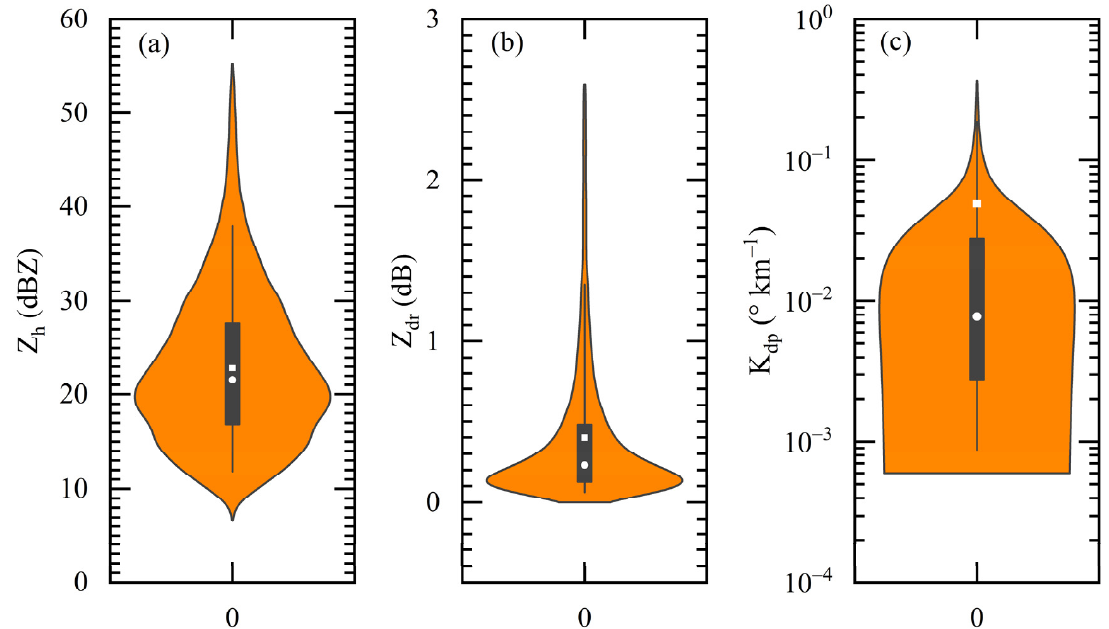
Figure 8 . Violin plots of ( a ) Z h , ( b ) Z dr , and ( c ) K dp derived from the DSD data in Zhaosu, showing the mean (white square), median (white dot), interquartile range (black rectangle), the 5th and 95th percentiles (whiskers), and the kernel density estimation (orange shading). The horizontal axis is the kernel density estimate (positive value), symmetrical around the axis midpoint 0. Table 3. The quantiles of variables for C ‐ band polarization radar derived from DSD observations.